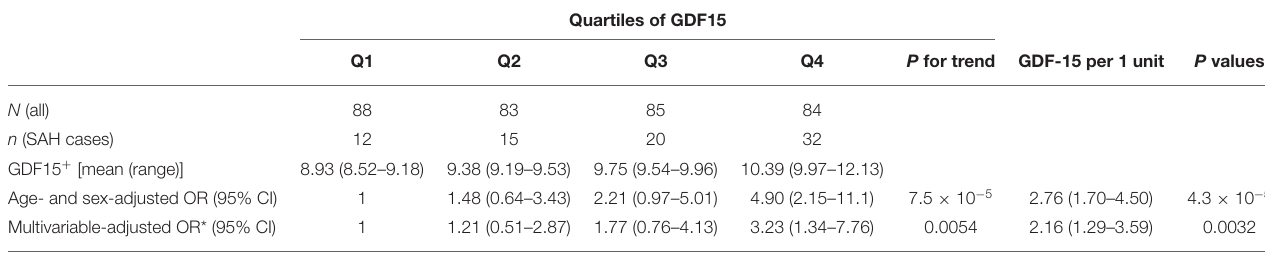
TABLE 4 | Association between GDF-15 and risk of